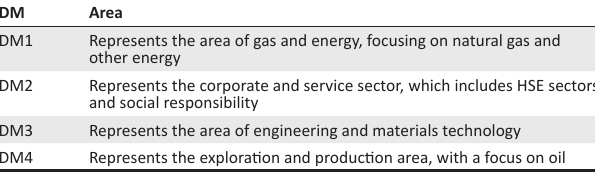
TABLE 4: Description of the role of the